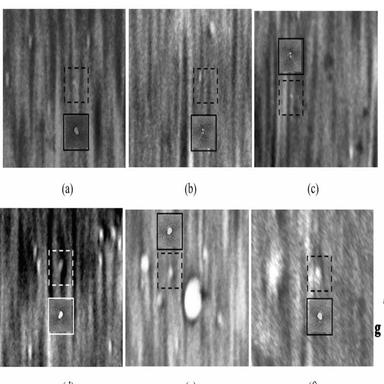
Six types of TEDs with the Burgers vectors of (a) 1 3 ; (b) 1 3 ; (c) 1 3 ; (d) 1 3 ; (e) 1 3 and (f) 1 3 . The insets of each topograph are the corresponding simulated images.